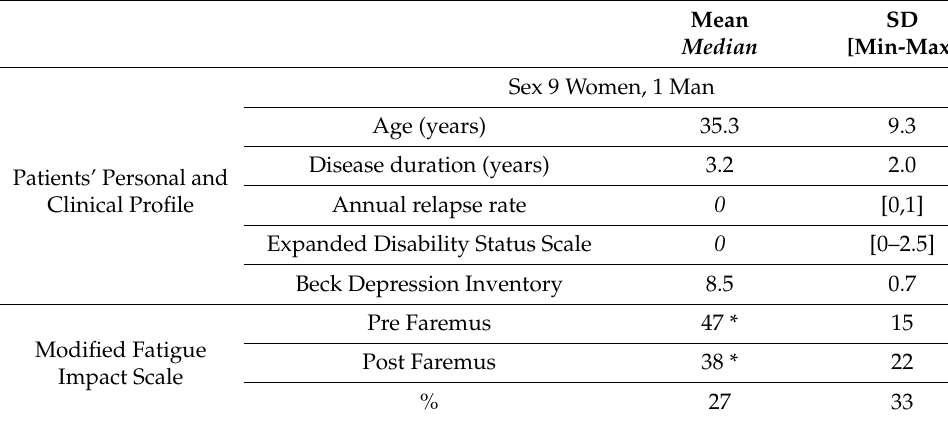
Table 1. MS patient clinical profile and fatigue with Faremus.